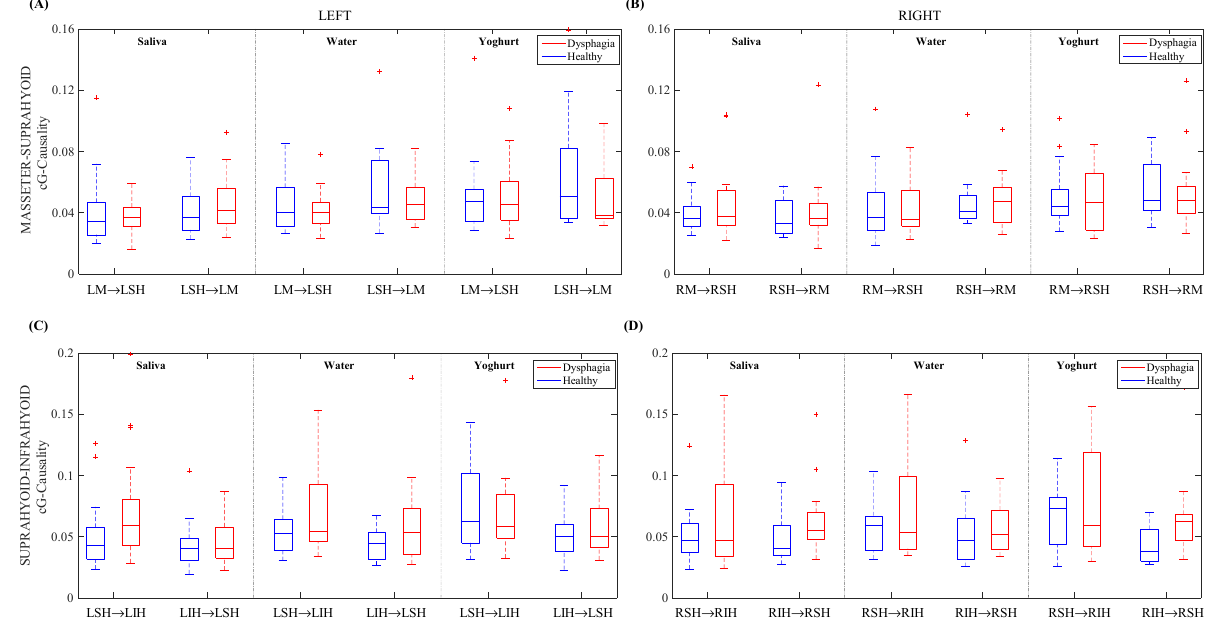
Figure 4. Box-and-whisker plot of the cG-causality for ipsilateral muscle interactions in healthy and dysphagic subjects for saliva, water, and yoghurt boluses. ( A ) LM ⟷ LSH, ( B ) LM ⟷ LSH, ( C ) LSH ⟷ LIH, and ( D ) RSH ⟷ RIH.